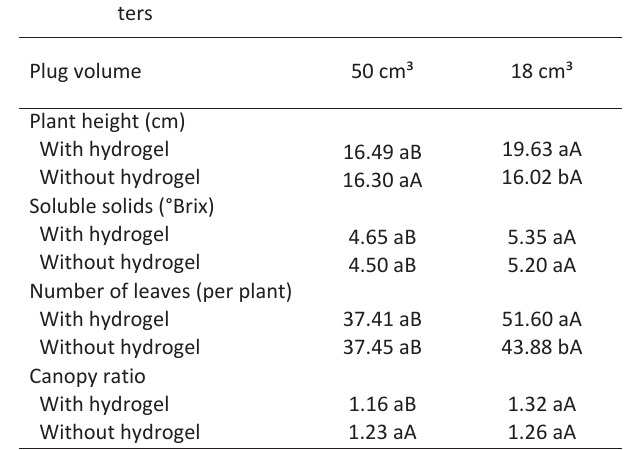
Table 2 - Interaction between hydrogel and seedling plugs vol- ume for plant ornamental/miniature tomato charac-